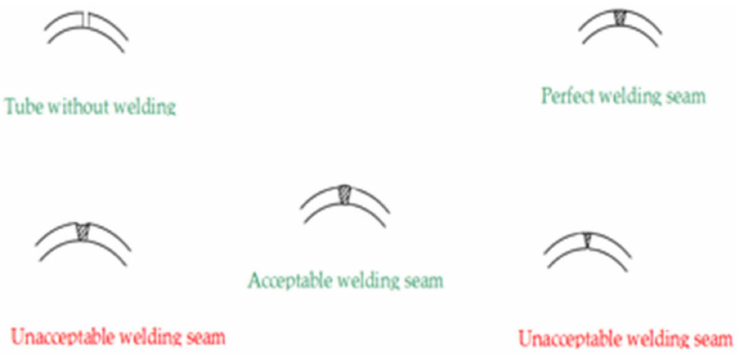
Figure 12. Welding seam